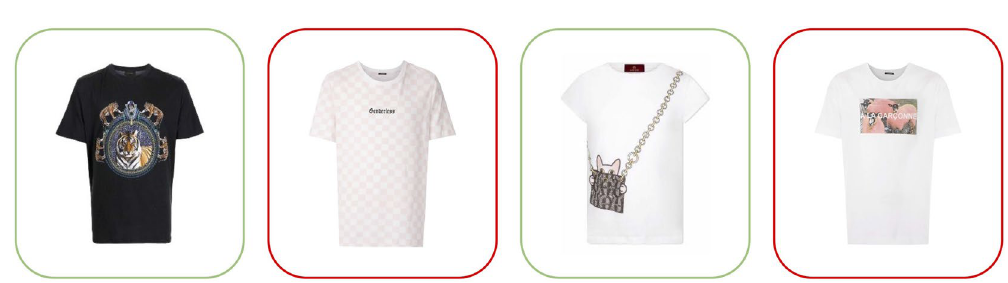
Figure 4. Retrieval with non-fashion concepts. Sample results for “t-shirt with tiger” and “t-shirt with cat” from FashionCLIP ( green ) vs Farfetch production search engine ( red ).